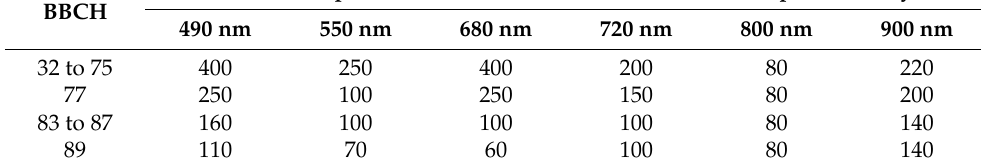
Table A1. Suitable relative exposures for the six wavebands of the Micro-MCA multispectral cam- era array depending on the BBCH development stage. Those values prevented saturation in the acquired images. Relative Exposures in the Six Wavebands of the Multispectral Array BBCH 490 nm 550